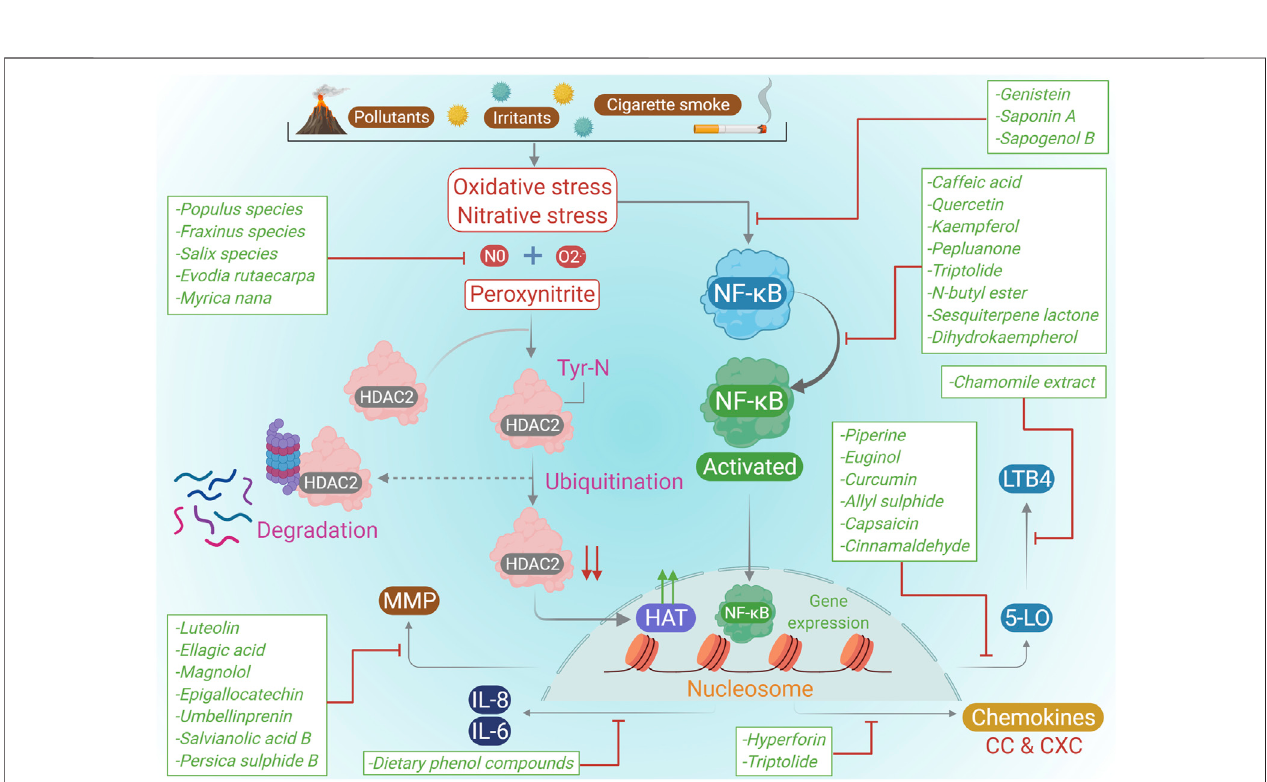
FIGURE 3 | Molecular mechanisms of COPD pathogenesis and the effects of natural plant